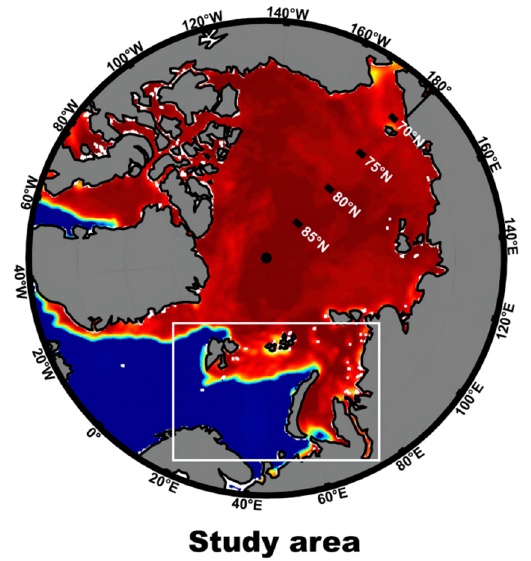
Figure 1. Study area in this study.